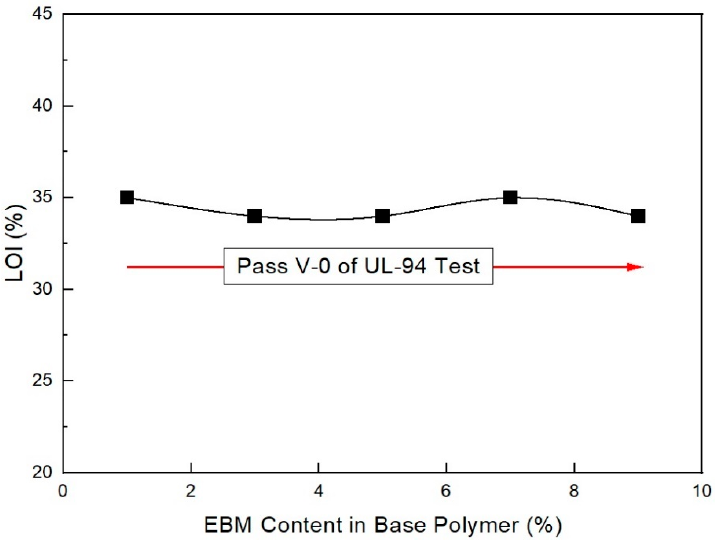
Figure 19. Flame retardancy of EVA/EXACT 8201/CLNA-8400/125 phr flame-retardant (MH+ZB+RP) formulations as a function of EBM content.